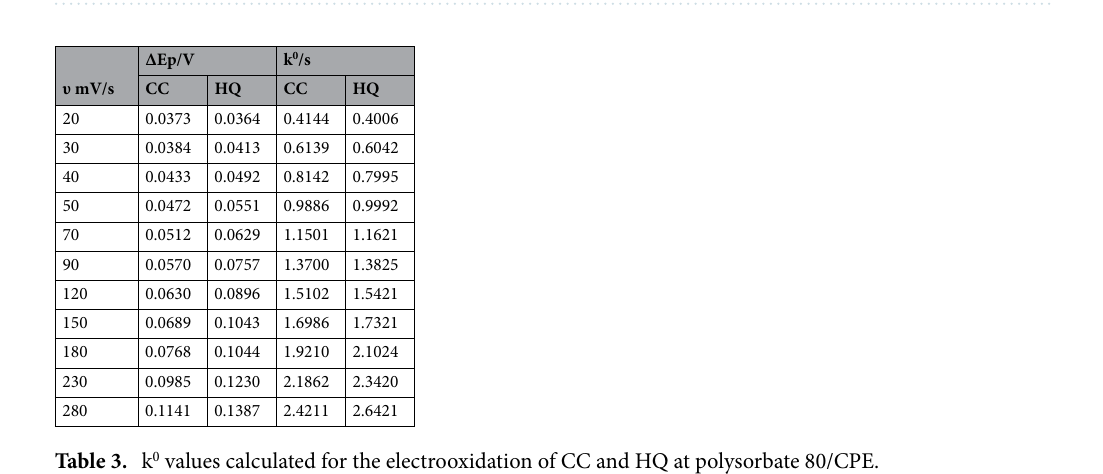
Figure 7. ( A ) Graph of Ip versus υ for CC. ( B ) Graph of Ip versus υ for HQ. (C) Graph of Ip versus υ 1/2 for CC. ( D ) Graph of Ip versus υ 1/2 for HQ.